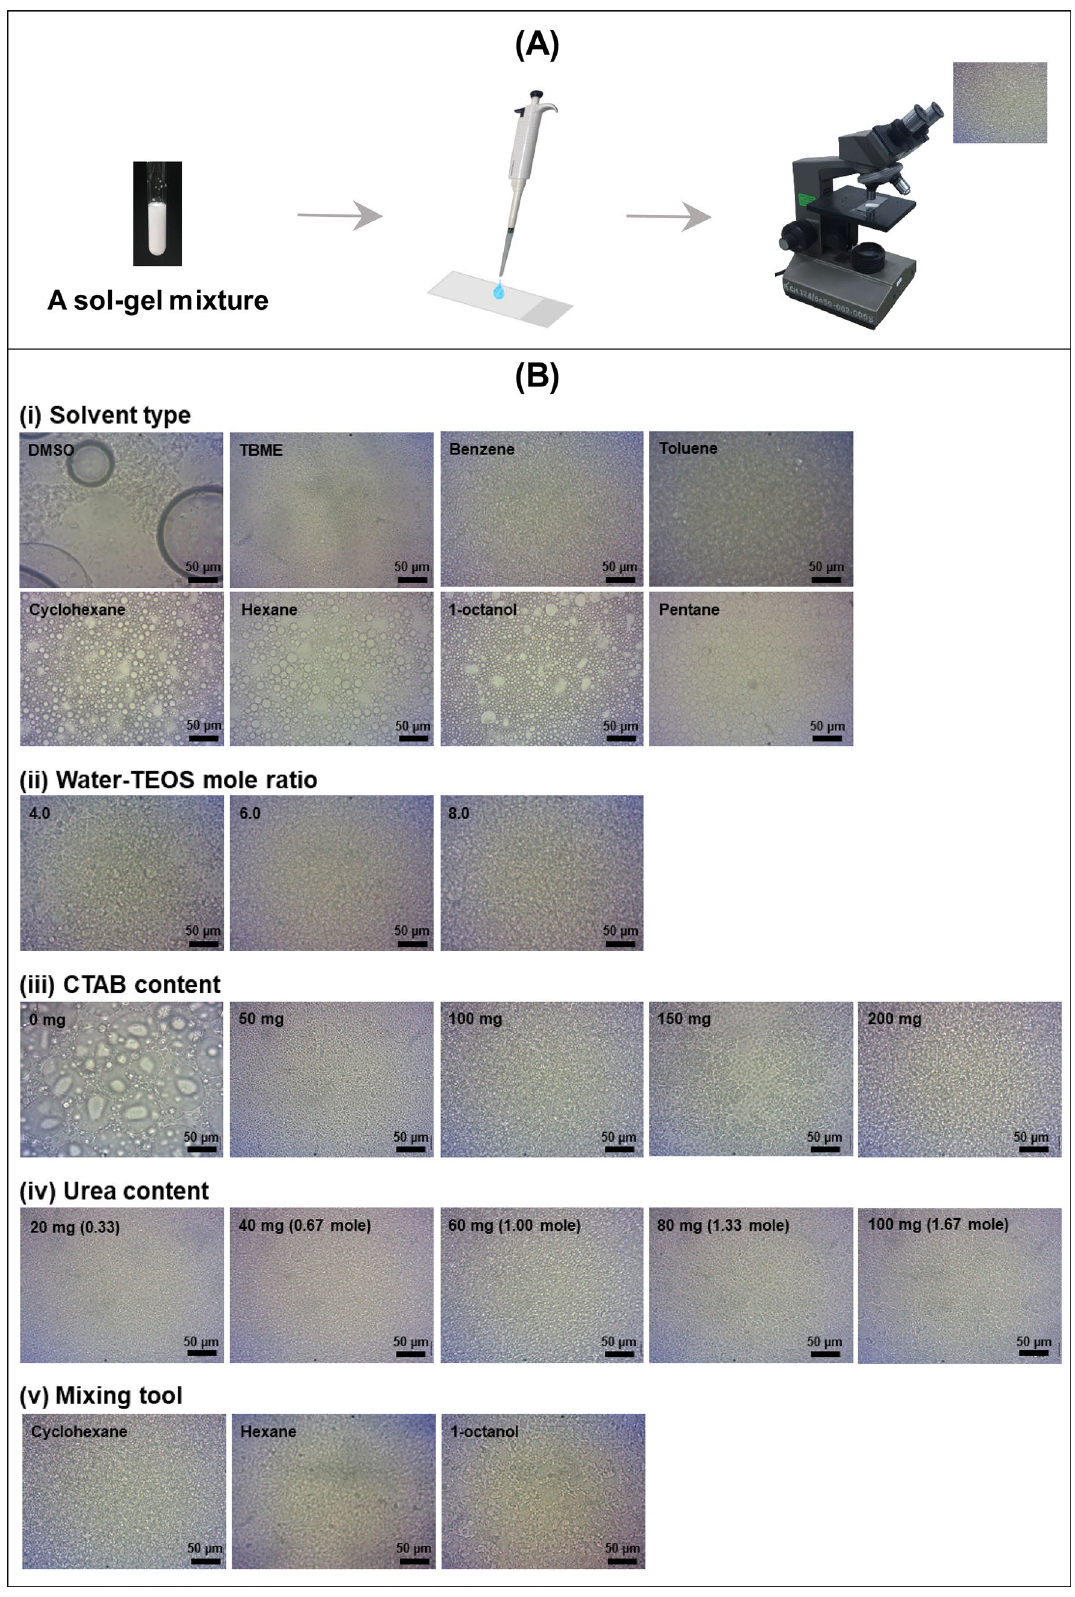
Figure 2. ( A ) Schematic of method for preparing sol–gel sample for observation on optical microscope. ( B ) Images recorded from an optical microscope showing features of gel for various sol–gel formulations. The parameters are (i) solvent type, (ii) water-TEOS mole ratio, (iii) CTAB content, (iv) urea content and (v) method of